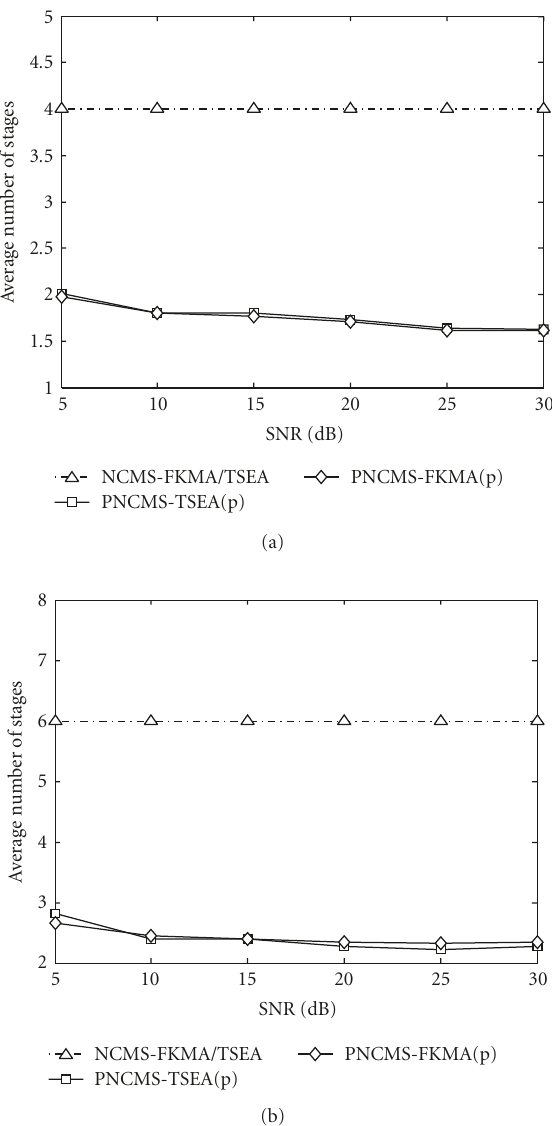
Figure 5: Complexity comparison results of Case A in Part C (number of iterations per source versus SNR): (a) A = A 1 and (b) A = A 2 .